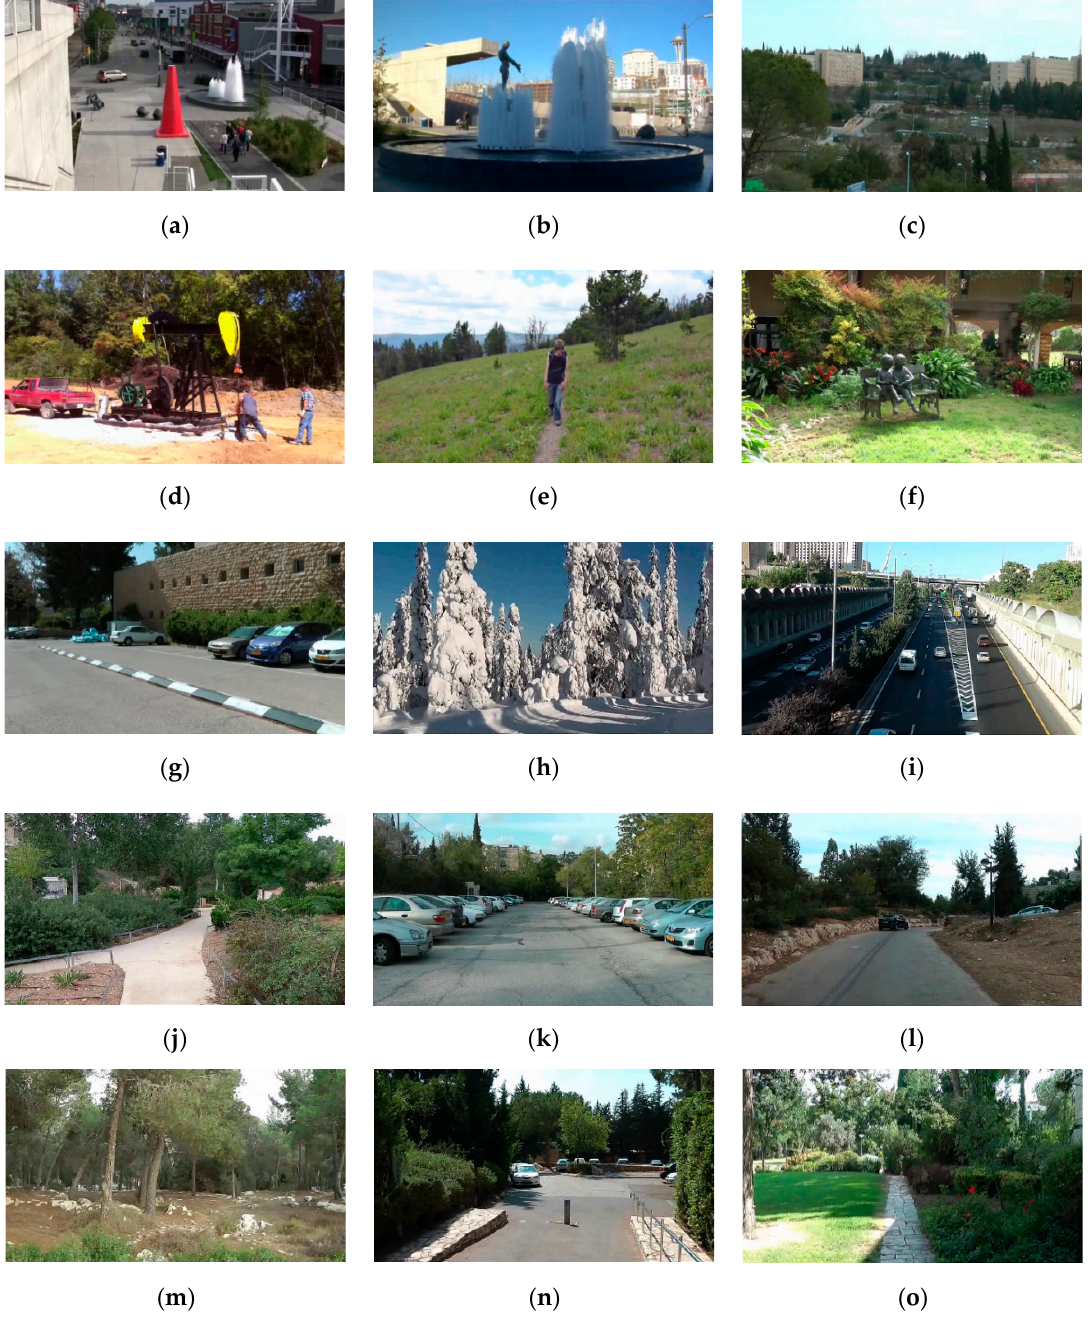
Figure 10. The tested image sequences. ( a ) Image sequence 2; ( b ) Image sequence 3; ( c ) Image sequence 4; ( d ) Image sequence 5; ( e ) Image sequence 6; ( f ) Image sequence 7; ( g ) Image sequence 8; ( h ) Image sequence 9; ( i ) Image sequence 10; ( j ) Image sequence 11; ( k ) Image sequence 12; ( l ) Image sequence 13 ( m ) Image sequence 14; ( n ) Image sequence 15; ( o ) Image sequence 16. Table 4. Features and ITF values of image sequences (dB).